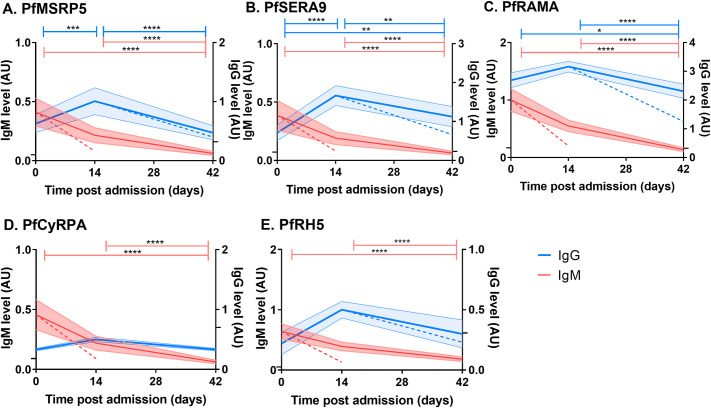
Longitudinal IgM and IgG specific for merozoite antigens in children with acute P. falciparum malaria.IgG (blue) and IgM (red) specific for PfMSRP5 (A.), PfSERA9 (B.) PfRAMA (C.), PfCyRPA (D.) and PfRH5 (E.) were measured longitudinally in children with acute P. falciparum malaria at day of diagnosis (Day 0), 2 weeks post-diagnosis (Day 14) and 6 weeks post-diagnosis (Day 42). Previously published IgG data for PfCyRPA and PfRH5 is included in the figure for visual comparison [47]. Cohort running means (thick line), their 95% confidence interval (shading) and catabolic decay (colored dashed lines) are shown. Longitudinal statistical significance (Friedman and Dunn’s post-hoc test) is represented by both asterisks (p<0.05 (*), p<0.01 (**), p<0.001 (***), p<0.0001 (****)) and colored lines (blue for IgG and red for IgM). Negative cut-offs are represented by a tick on each Y axis.